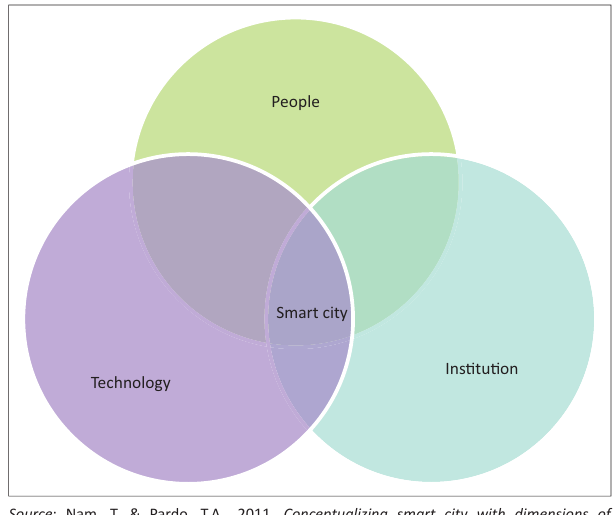
FIGURE 1: Three key components of a smart city